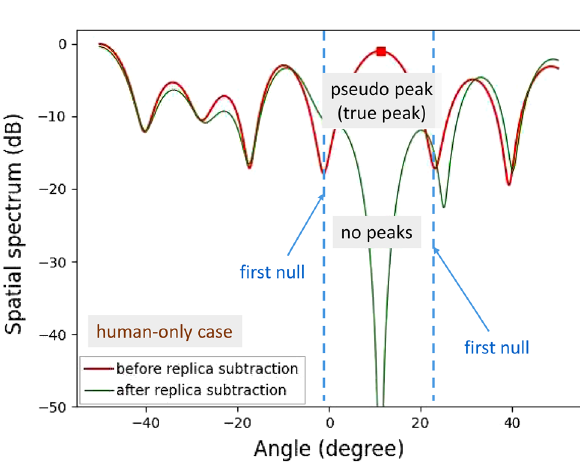
Figure 12. Demonstration environment for horizontal angle estimations of on-road obstacles: human and bicycle.